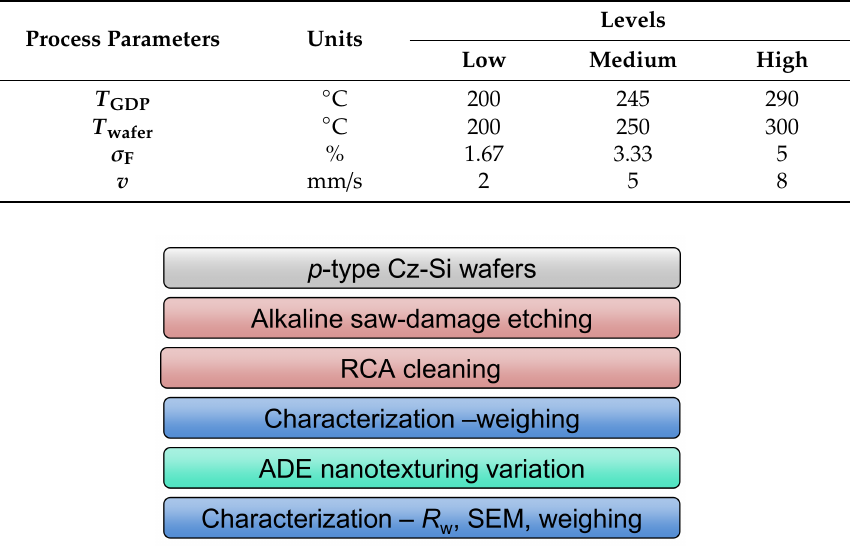
Figure 2. Process flow of the wafers used for the statistical design of